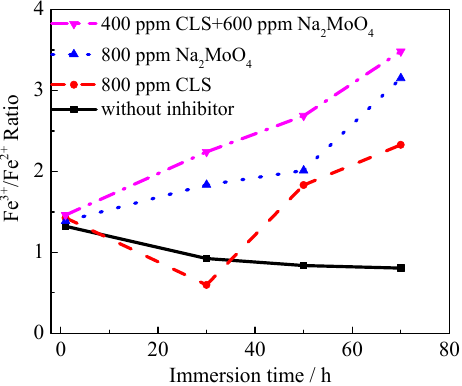
Figure 11. The Fe 3+ /Fe 2+ ratio for Q235 steel immersed in test solution with different inhibitors.